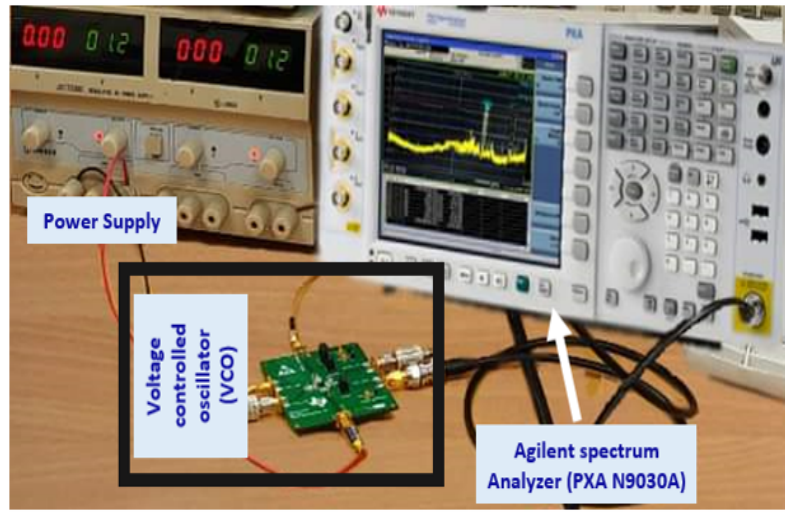
Figure 18. Experimental set-up of the proposed research. Table 3. Performance summary of the state-of-art and the wide-FTR